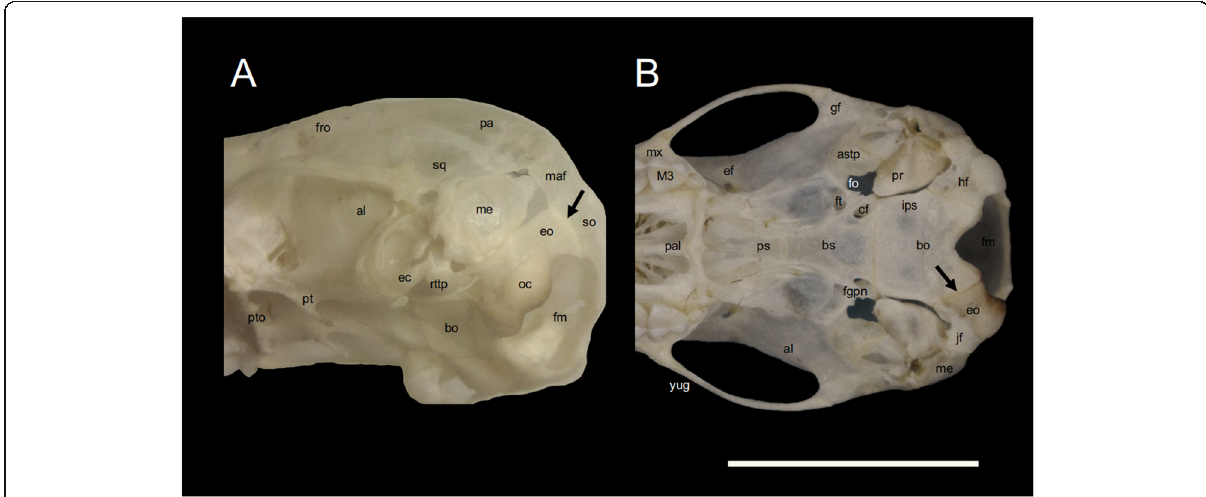
Fig. 3 Occipital complex and basicranium of Rhyncholestes raphanurus Osgood, used to show the sutures between supraoccipital and exoccipital bones (black arrow in A), and exoccipital and basioccipital bones (black arrow in B), based on specimen FMNH 129828 ♀ . Abbreviations: al, alisphenoid; astp, alisphenoid tympanic process; bo, basioccipital; cf., carotid foramen; ec, ectotympanic bone; ef, ethmoidal foramen; eo, exoccipital; fgpn, foramen for the greater petrosal nerve; fm, foramen magnum; fo, foramen ovale; fro, frontal; ft., foramen transversum; gf, glenoid fossa; hf, hypoglossal foramina; ips, inferior petrosal sinus; jf, jugal foramen; M3, third upper molar; maf, mastoid fenestra; me, mastoid exposure of the petrosal bone; mx, maxillary; pa, parietal; pal, palatine; pr, promontorium of the petrosal bone; pt., pterogoid; rttp, rostral tympanic process of the petrosal; so, supraoccipital; sq., squamosal; oc, occipital condyle; pto, palatine torus; yug, yugal. Scale bar: 1